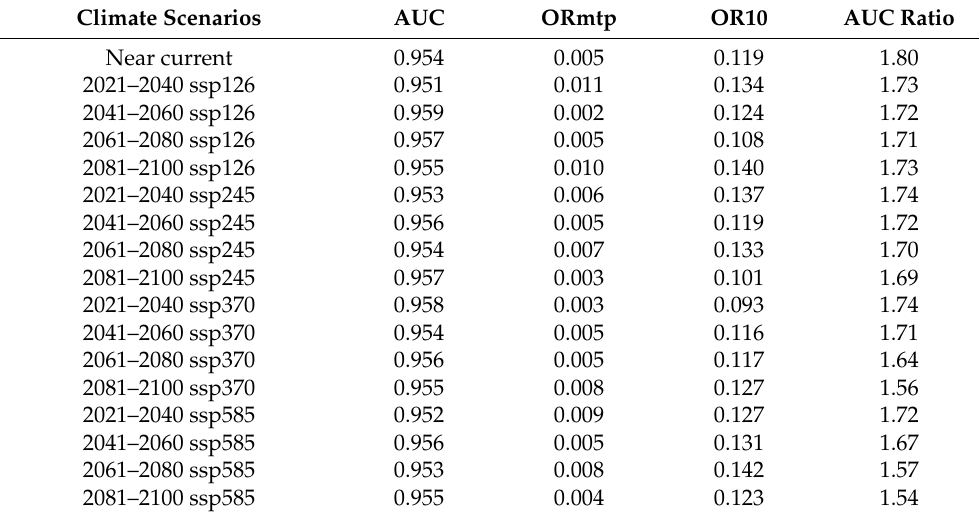
Table 3. The predictive accuracy of the maximum entropy model estimated by AUC, ORmtp, OR10, and AUC